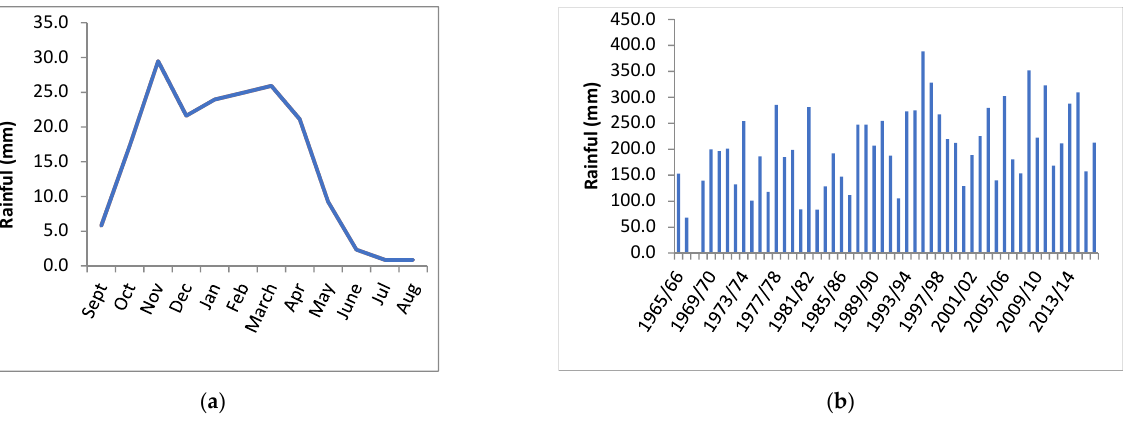
Figure 4. ( a ) Average monthly rainfall distribution in the station of Chichaoua (1965–2014); ( b ) Average annual rainfall distribution in the station of Chichaoua.